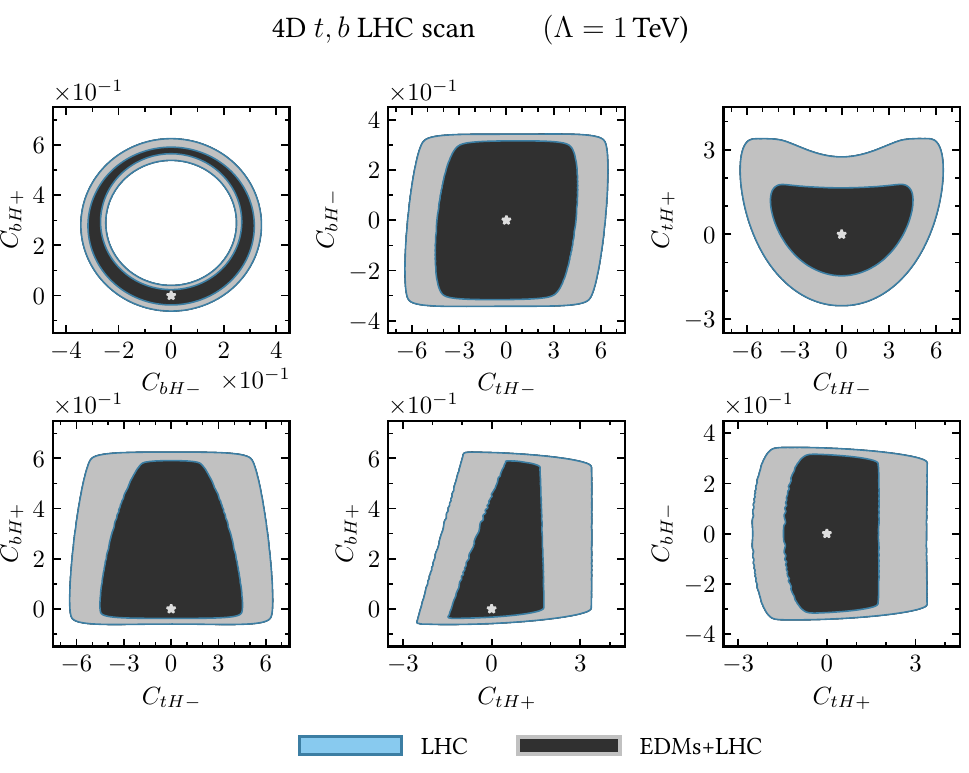
Figure 11 . LHC constraints resulting from a 4D scan of top and bottom Wilson coefficients ( C tH ± , C bH ± ) assuming Λ = 1 TeV. In each plot only two parameters are shown, the remaining ones are profiled over (see main text). Contours represent the allowed 68% and 95% confidence regions, the colour coding of individual constraints is given in the legend, and grey/black areas correspond to the combined regions. For details see main text and the caption of figure